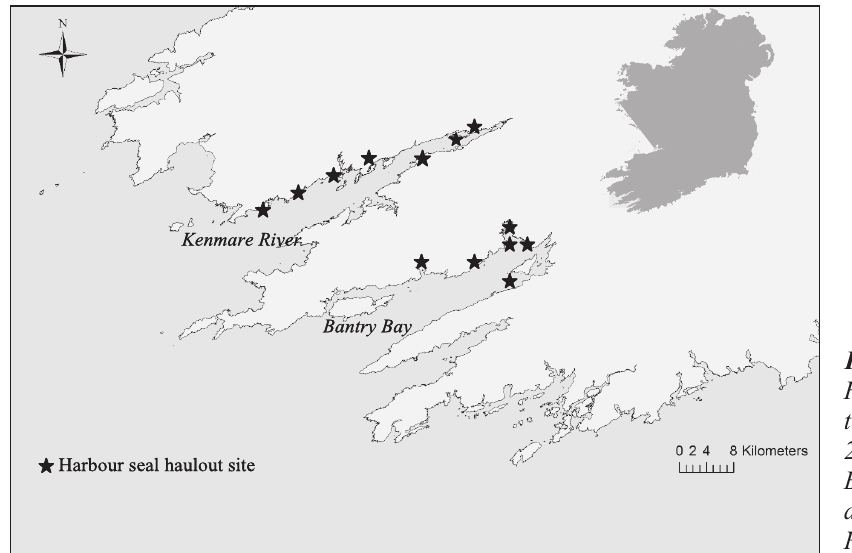
Fig. 1. Haulout loca- tions within